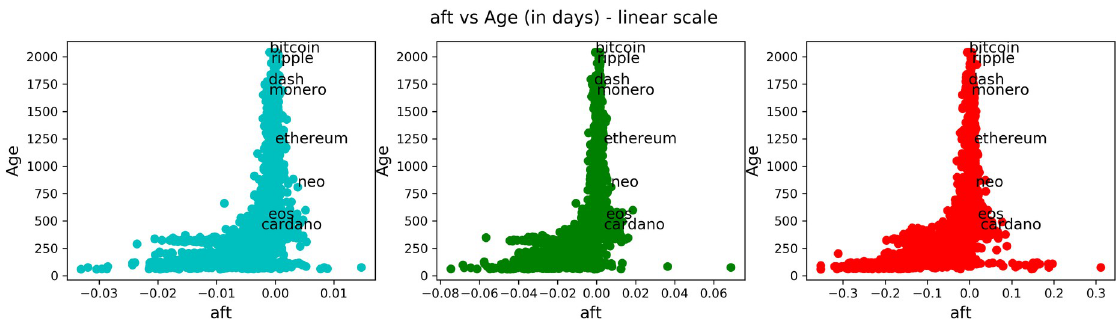
Fig 8. Comparison of anti-fragility values and age in cryptocurrencies. Each subplot corresponds to a timescale. The plots compare the corresponding A measure (x-axis) to the ‘good-performance’ measure age . We observe how higher values of the ‘good-performance’ measure concentrate in the robust axis A = 0